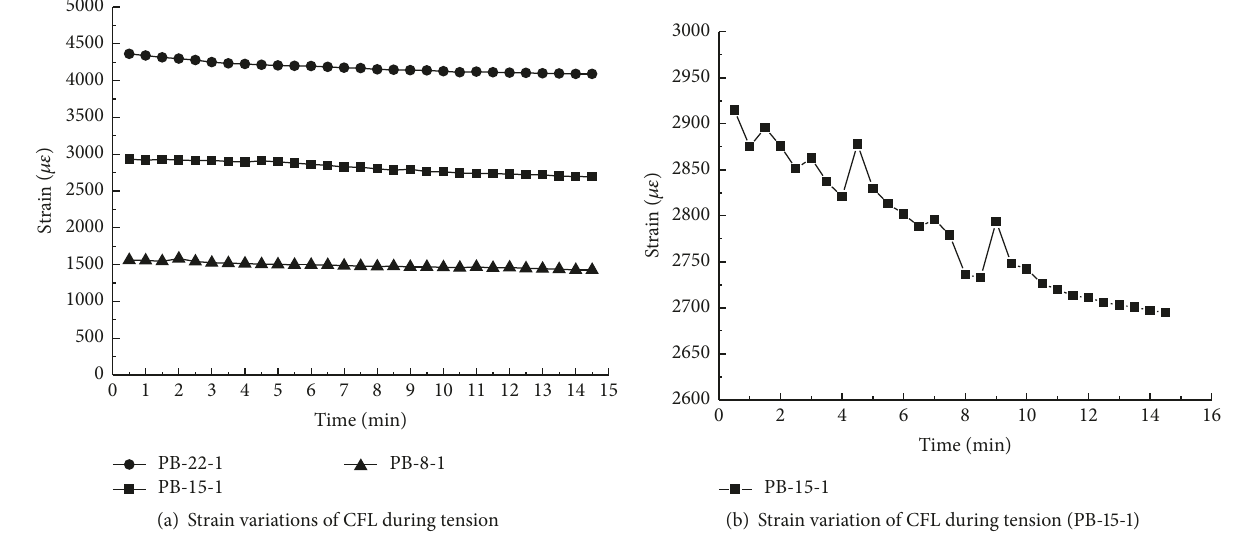
Figure 6: Strain variations of CFL during tension.